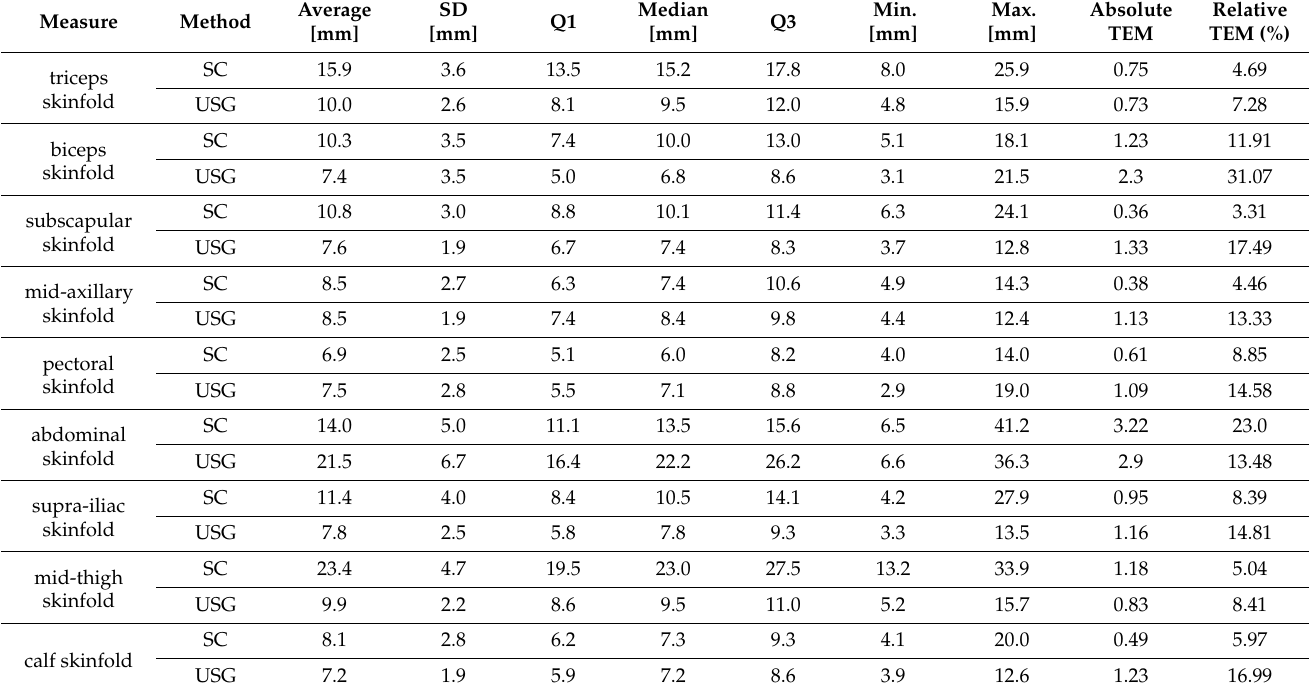
Table 1. The thickness of the subcutaneous adipose tissue in the study sample ( n = 58 women). USG represents a measurement taken using the ultrasound scanner; SC represents a measurement taken using the skinfold caliper. Q1 and Q2—quartiles 1 and 2, respectively. TEM—technical error of